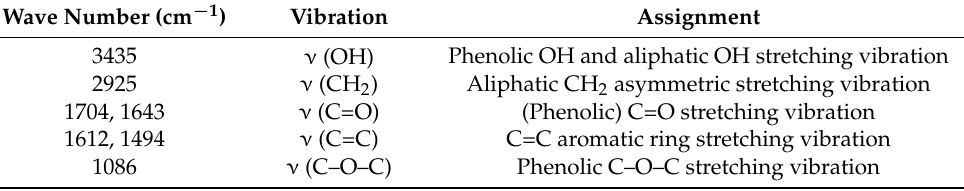
Figure 1. Fourier transform infrared (FT-IR) spectrum of cured PR and BPRs. Table 3. Peaks and assignment of FT-IR spectra for cured PR and BPRs.